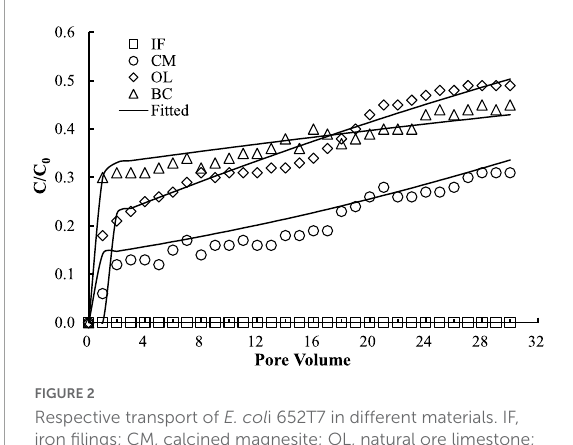
FIGURE3 Respective transport of MS2 in different materials. IF, iron filings; CM, calcined magnesite; OL, natural ore limestone; BC, corn stalk biochar. The lines are the modeling results with advection-dispersion equation using the Hydrus-1D software.